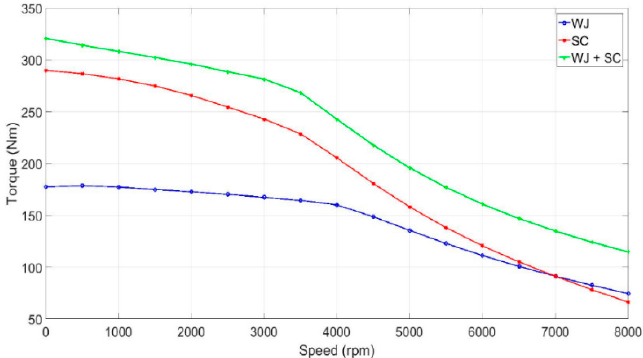
Figure 24. Variation in continuous torque with spray-cooling and without spray-cooling [76].